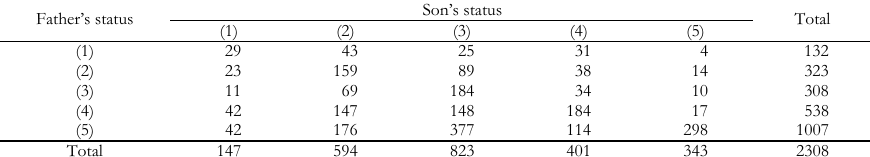
The data are cross-classification of father’s and his son’s social classes in Japan (Hashimoto, 1999, p.